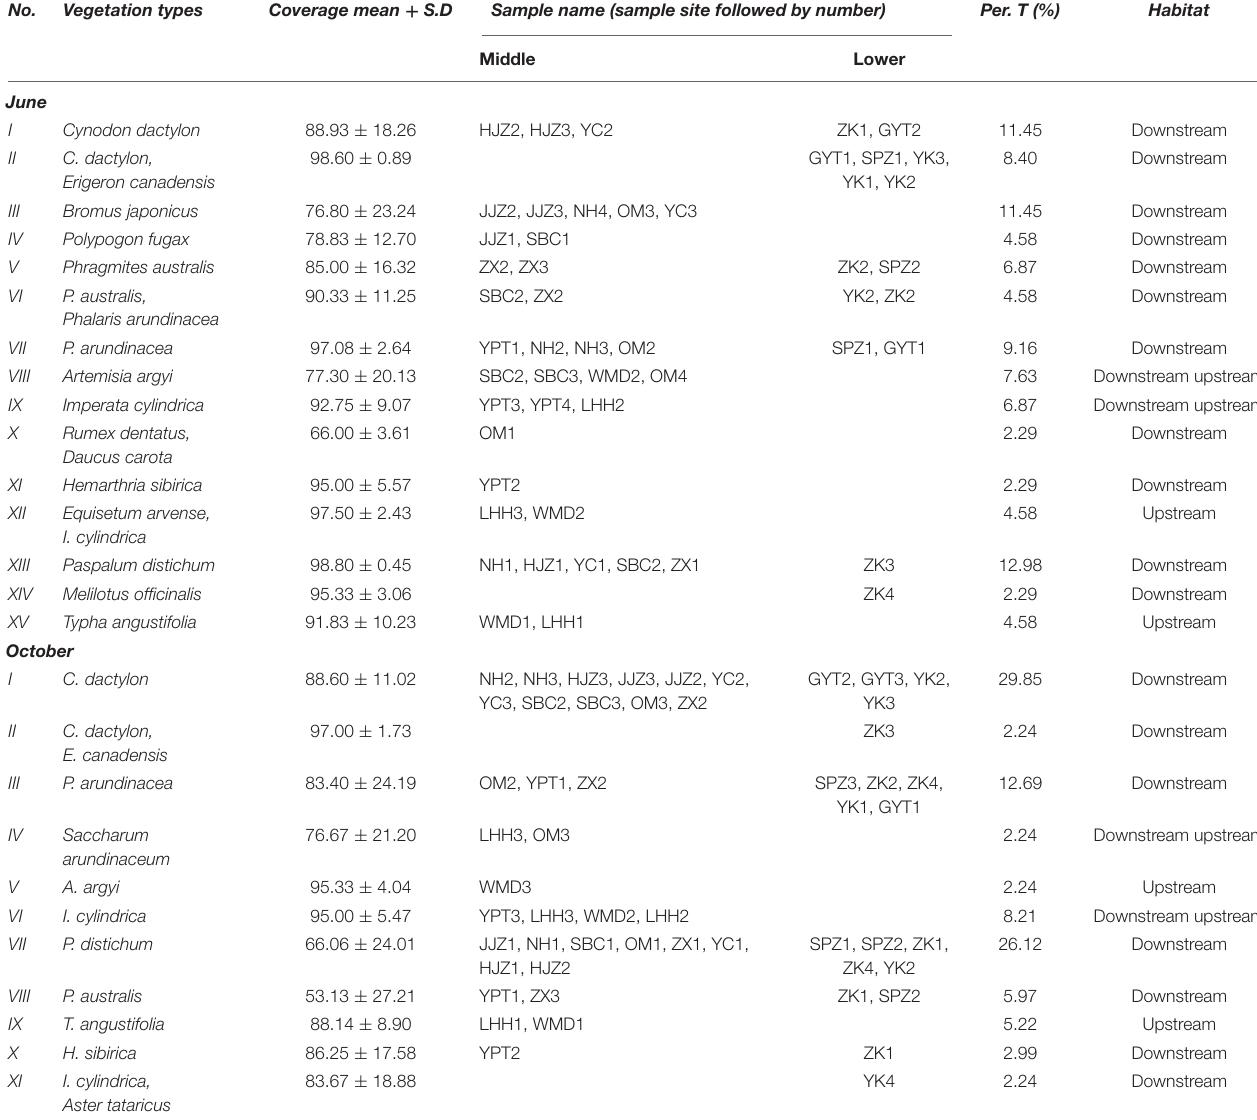
TABLE 1 | Vegetation types in the riparian zone along the middle and lower reaches of the Hanjiang River. No. Vegetation